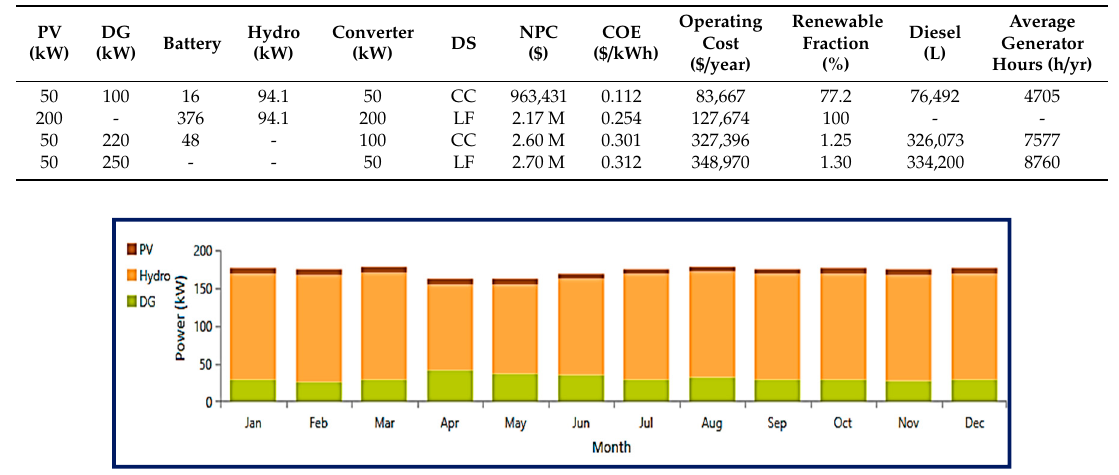
Figure 9. Monthly electric power production.